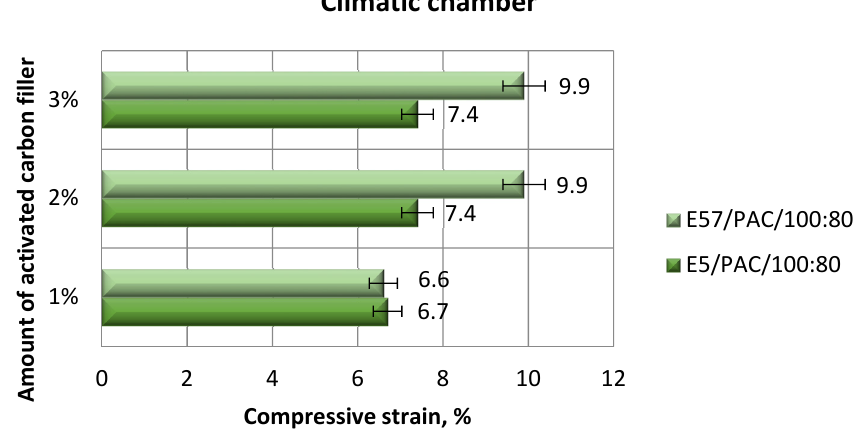
Figure 17. Comparison of the compressive strain between the E5/PAC/100:80 and E57/PAC/100:80 epoxy specimens modified by the activated carbon filler post ‐ climate chamber aging.